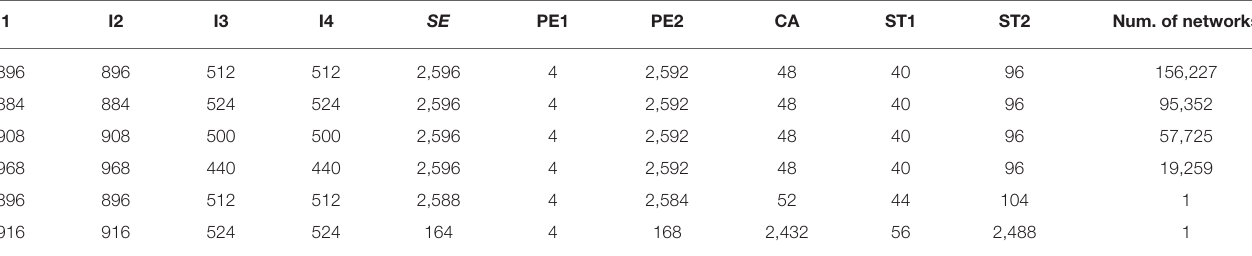
Cyclic attractors were prohibited in the query. There are only six different combinations of basin sizes. The last column shows the number of Boolean networks having the corresponding combinations of basin sizes.